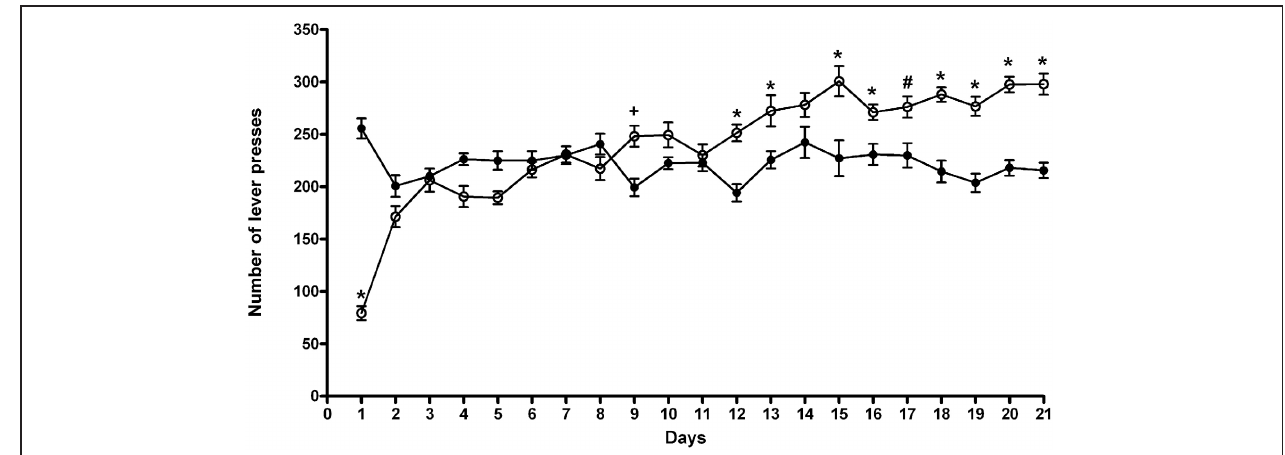
FIGURE 1 | Number of lever presses during the 21 days of training period. Each value represents the means ± S.D. of 16 rats. # p < 0 . 05; + p < 0 . 01; ∗ p < 0 . 001 vs. control groups. ( ) CTR, ( )